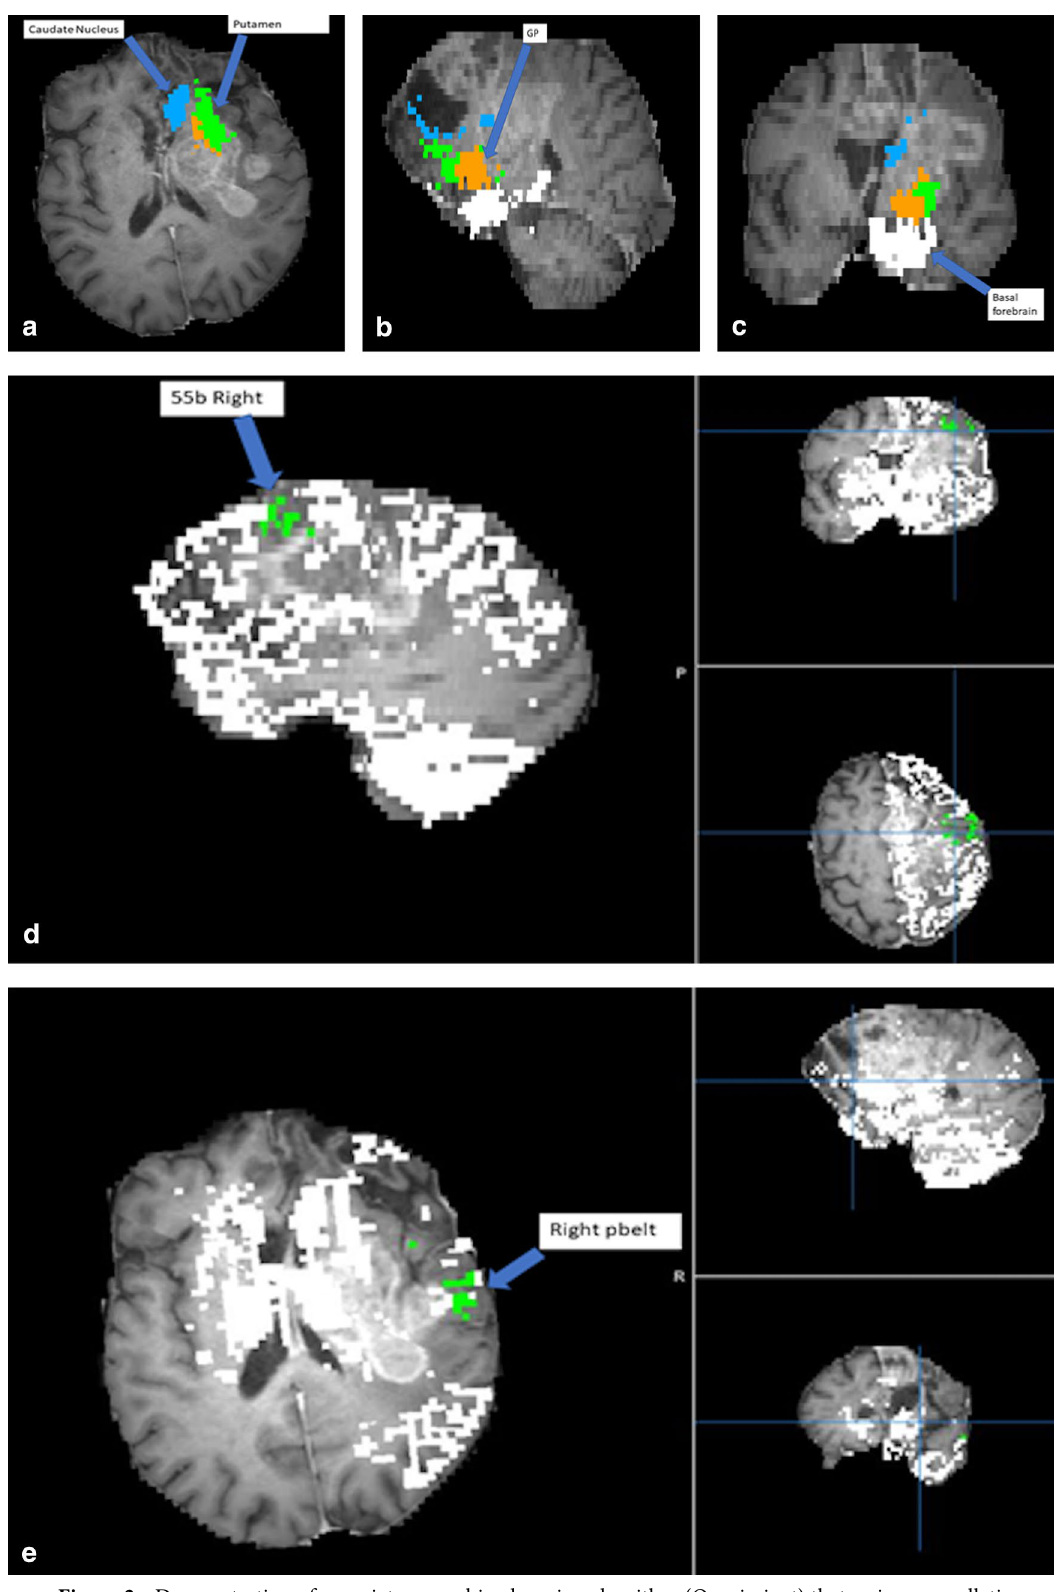
Figure 2. Demonstration of proprietary machine learning algorithm (Omniscient) that assigns parcellations to very distorted brains. Patient with a frontal lobe GBM and resected regions resulting in total anterior brain shift. ( a ) Displays the modified location of the caudate nucleus and the putamen. ( b ) Displays the modified location of the GP. ( c ) Displays the modified location of the basal forebrain. ( d ) Displays the modified location of right 55b parcellation. ( e ) Displays the modified location of the right PBelt. This allows for the creation of a connectivity matrix of any brain